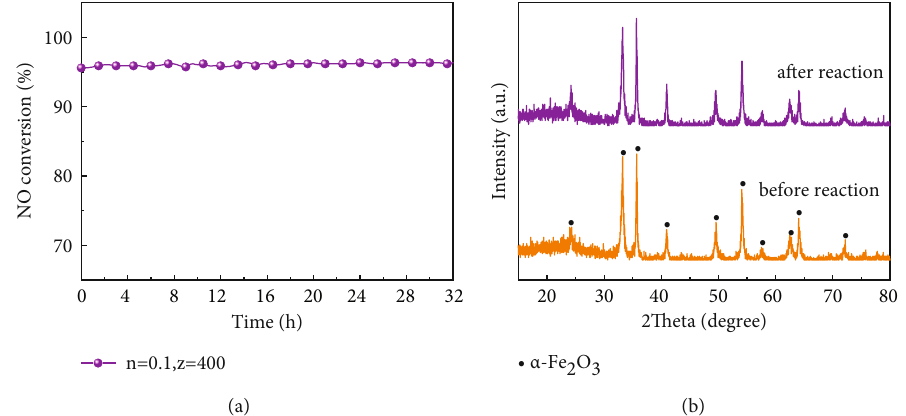
Figure 8: (a) Stability test of MnO